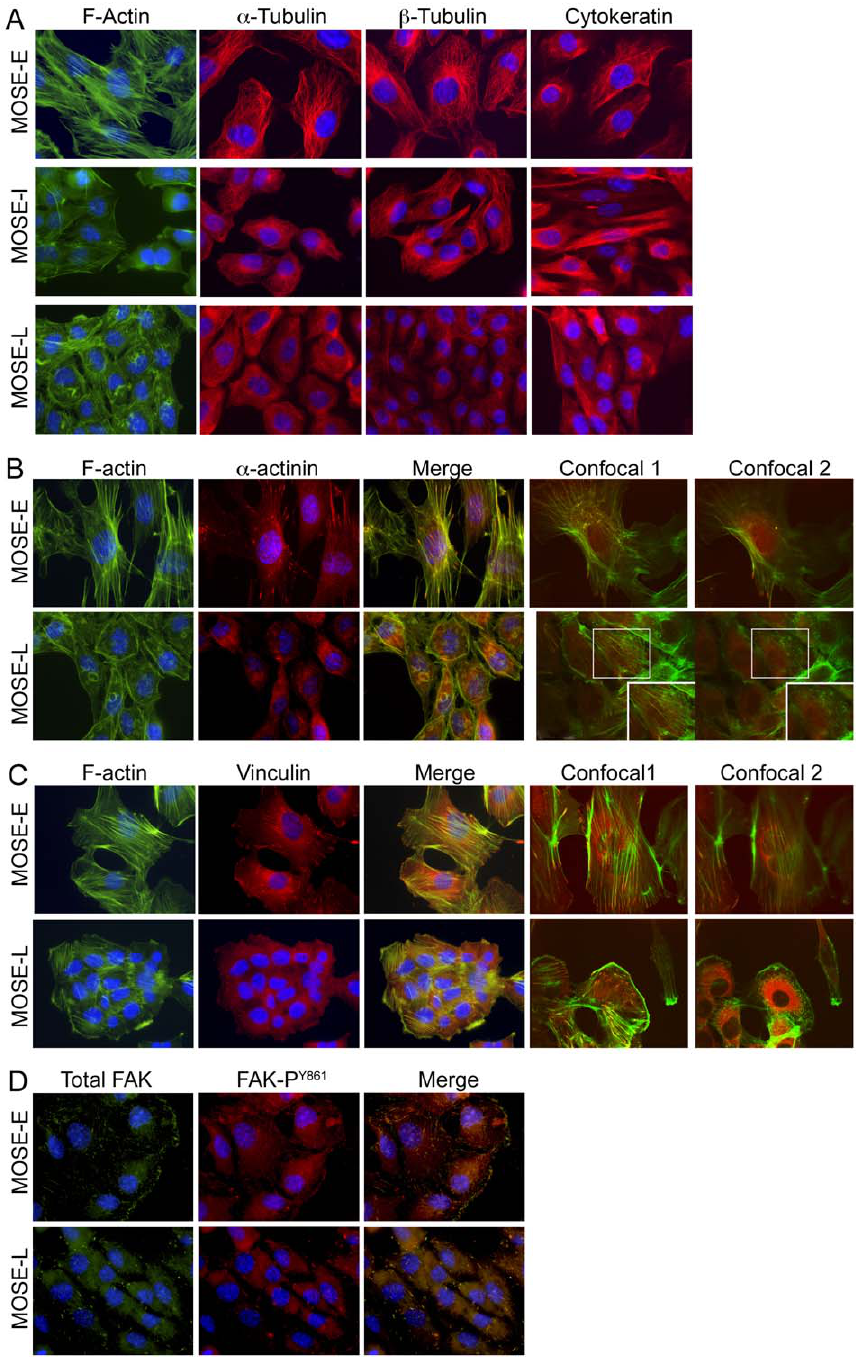
Figure 3. Organization of the cytoskeleton and localization of actin regulating proteins with neoplastic progression. ( A ) Immunofluorescent staining of MOSE-E, MOSE-I and MOSE-L cells to visualize actin filaments (phalloidin, green), a - tubulin (2 nd column), b - tubulin (3 rd columns), or cytokeratin (4 th column) along with the nucleus (blue, DAPI). ( B and C ) Triple staining of MOSE-E and MOSE-L cells with DAPI (blue), phalloidin (f-actin, green), and antibodies against a -actinin (red, B) or vinculin (red, C). The confocal images shown are 0.6 m m apart within the cell, with image 1 starting at the base of the cell and image 2 towards the top of the cell. Co-localization appears as yellow in merged and confocal images. ( D ) Triple staining of MOSE-E and MOSE-L cells with DAPI (blue), antibody against FAK (green), and antibody against FAK phosphorylated tyrosine 861 (red, FAK Y861 ). Yellow in merged image indicates co-localization. (Original magnification X600) doi:10.1371/journal.pone.0017676.g003 localization of a -actinin (red) with actin filaments (green) running diffuse staining in the cytoplasm with considerably less evident co- parallel to the leading edge was always readily apparent in MOSE- localiziation with actin filaments (Figure 3B, red). This was also E cells (Figure 3B). In MOSE-L cells, a -actinin appeared largely as observed in MOSE-I cells (data not shown). Confocal microscopy